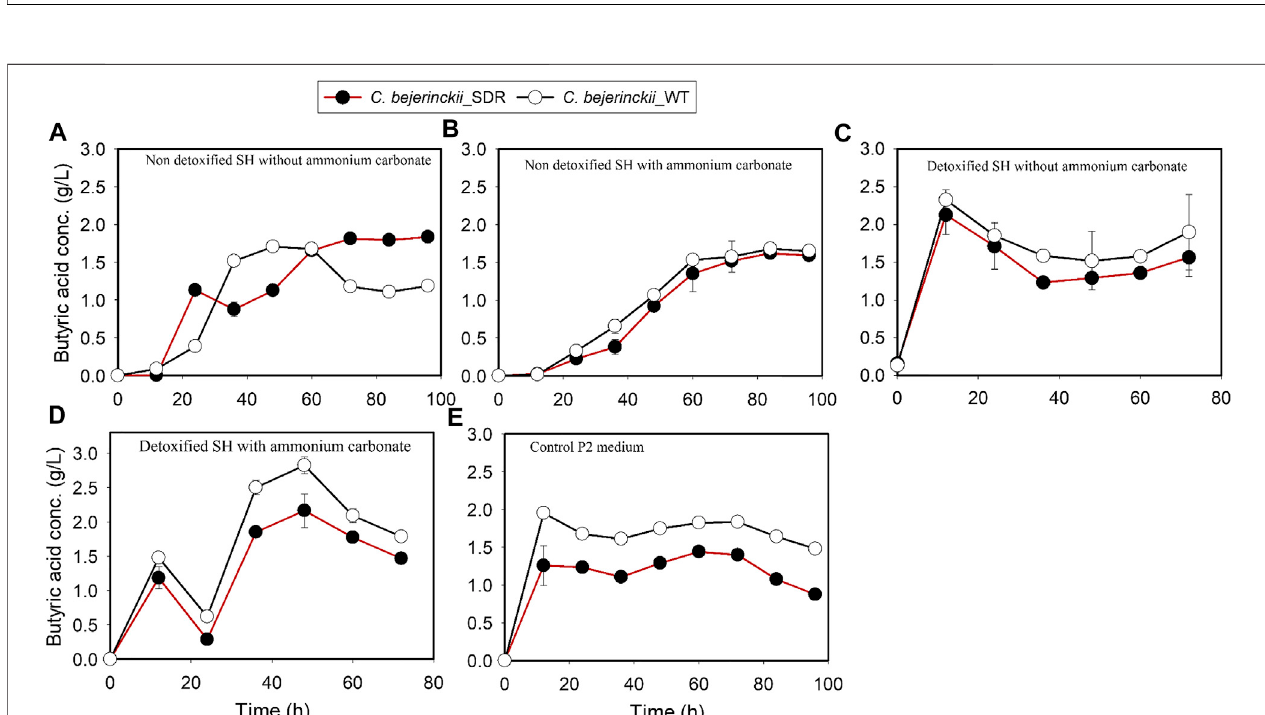
FIGURE 4 | Butyric acid concentration pro fi les in the fermentation media using C. beijerinckii _SDR or C. beijerinckii _wildtype. (A) Non-detoxi fi ed SH without ammonium carbonate. (B) Non-detoxi fi ed SH with ammonium carbonate. (C) Detoxi fi ed SH without ammonium carbonate. (D) Detoxi fi ed SH with ammonium carbonate. (E) Control P2